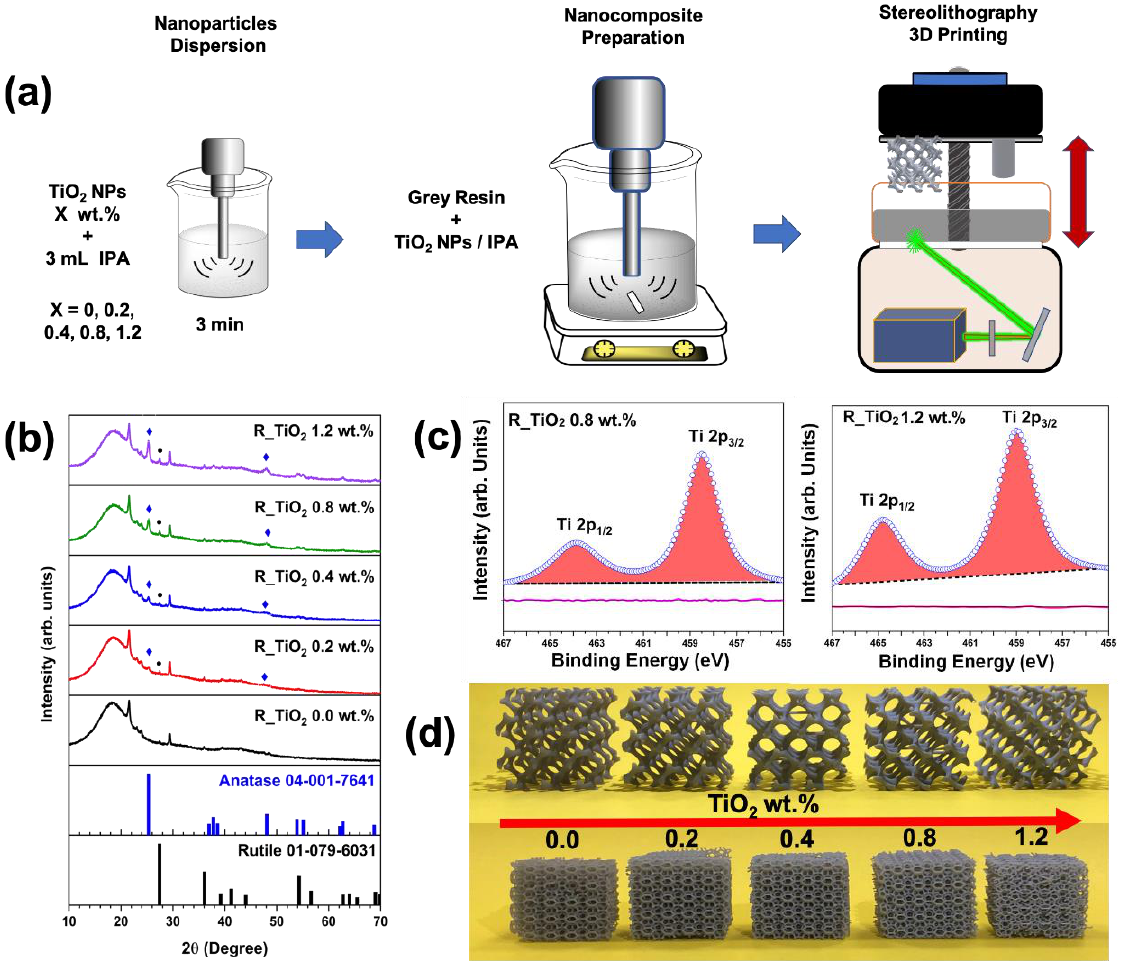
Figure 1. ( a ) Schematic representation of how to achieve stereolithographically 3D-printed polymer nanocomposites based on resin/TiO 2 NPs (R_TiO 2 X wt.%) at several concentrations of TiO 2 NPs (0.0, 0.2, 0.4, 0.8, and 1.2); ( b ) XRD patterns for all 3D-printed nanocomposites; ( c ) HR-XPS curves corresponding to polymer nanocomposites at 0.8 and 1.2 wt.% TiO 2 NPs; and ( d ) printability demon- stration of hollow structures (gyroid type), compression test specimens, and complex structures (dense